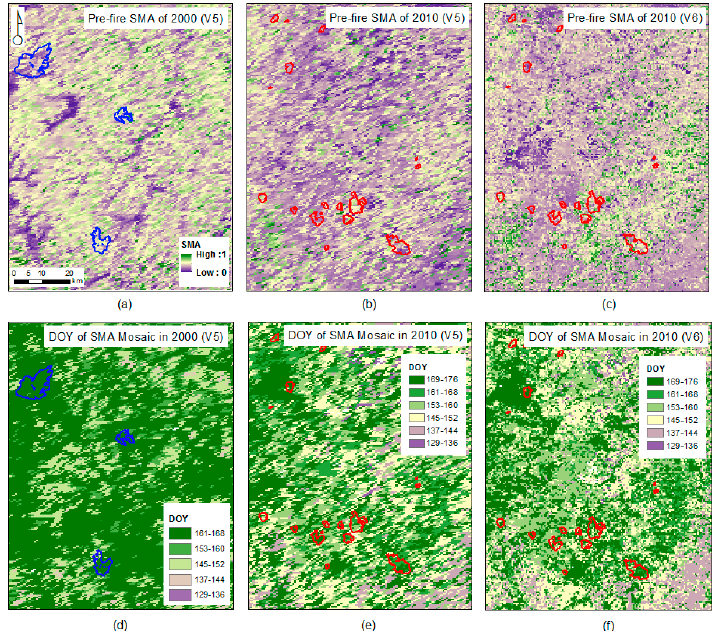
Figure A1. The integrated pre-fire surface moisture availability (SMA) of 2000 ( a ) and 2010 ( b , c ) derived from 8-day MODIS MOD16A2 Version 5 ( b ) and Version 6 ( c ) product. The good quality pixels selected from five 8-day MOD16A2 datasets ( d – f ) were composited. Fire patches of 2000 (in blue, a , d ) and 2010 (in red, b , d – f ) were also plotted.